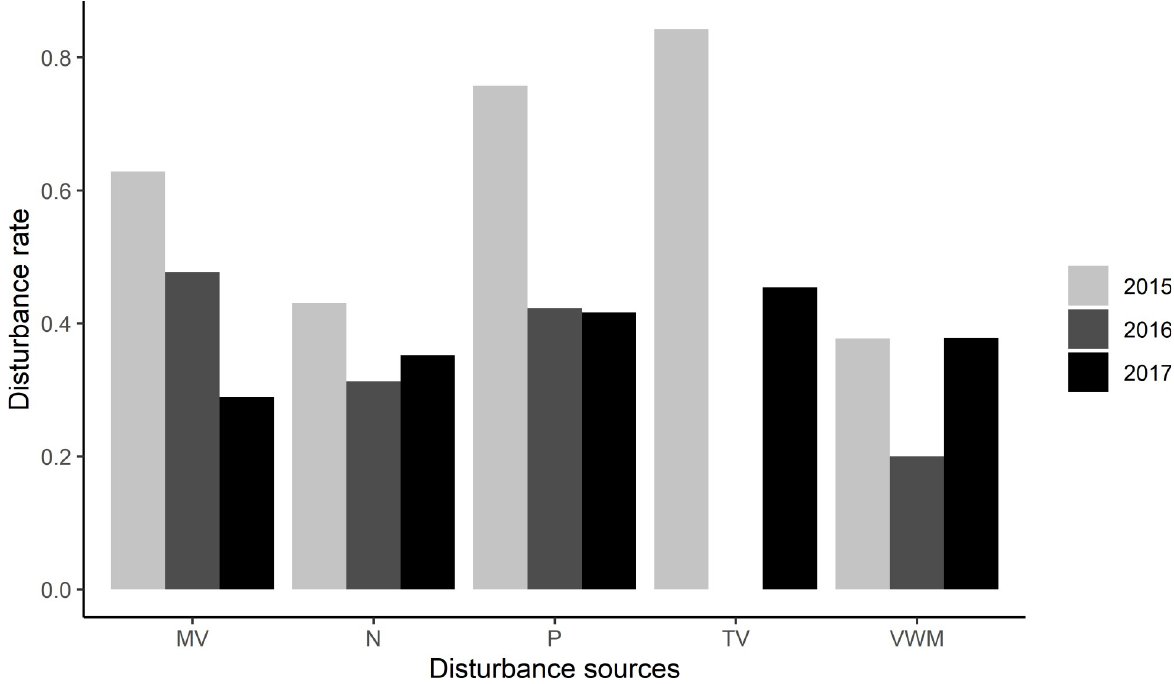
Fig 3. Disturbance rates (number of disturbance events/h) at PBE over three breeding seasons (white—2015, grey—2016, and black—2017). Disturbance sources: P = pedestrians; MV = motorized vessels; VWM = vessels without motor; TV = terrestrial vehicles; and, N = noise.